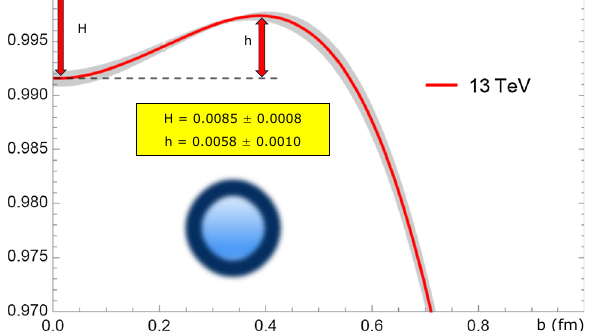
lowness effect is a small but significant, much more than a 5 σ effect, characterized by a hollowness strength param- eter of h = 0 . 0058 ± 0 . 0010. The value of the depres- sion at b = 0 is even more significant, it is character-